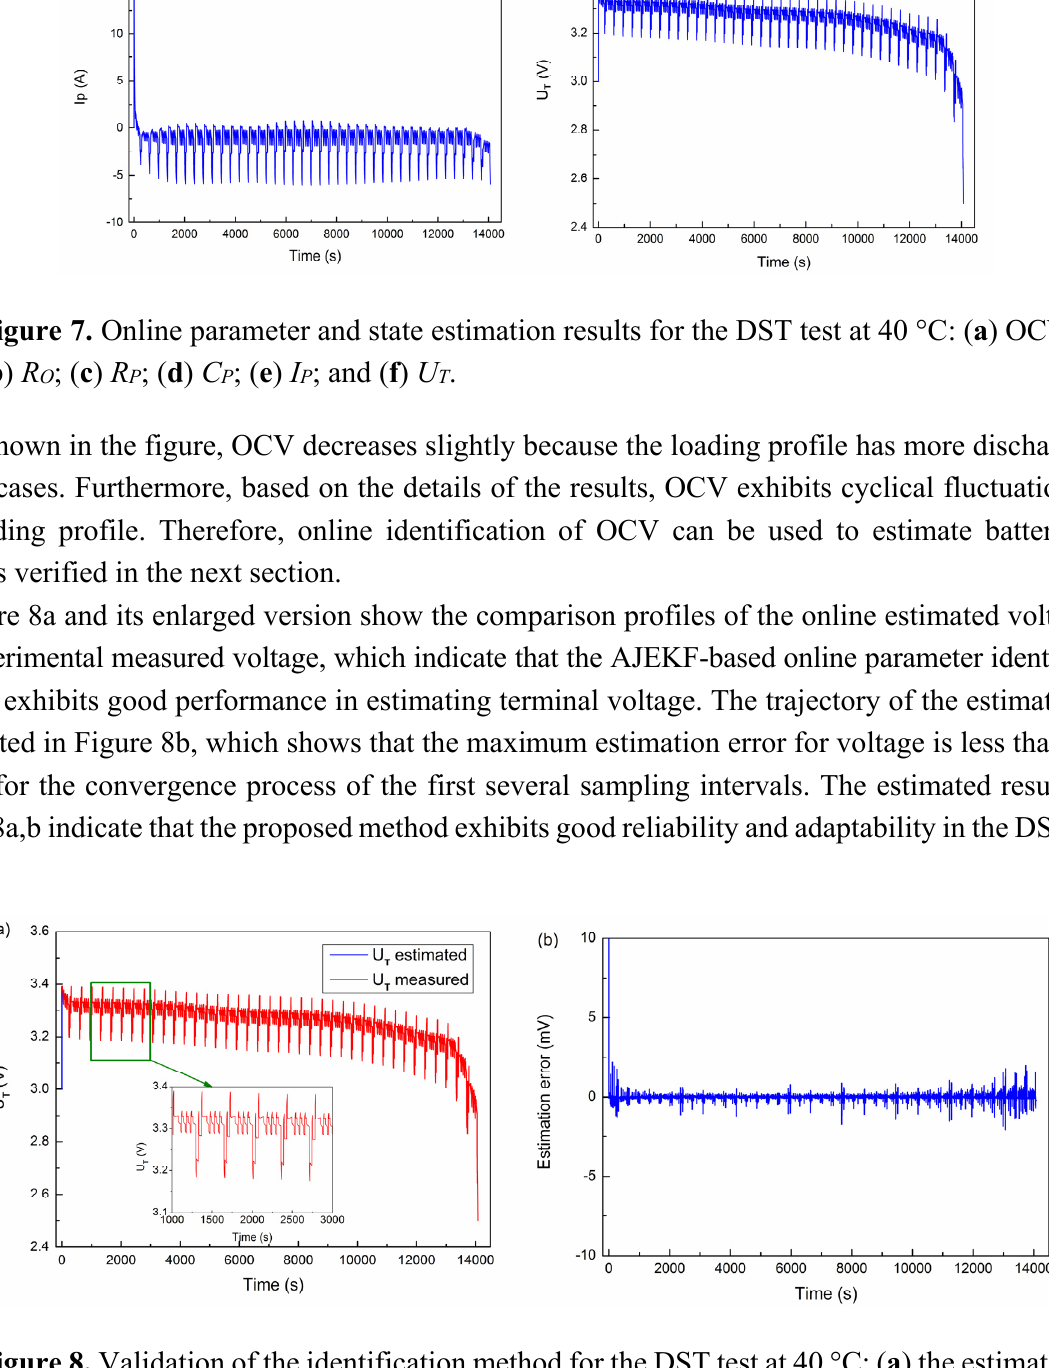
Figure 8. Validation of the identification method for the DST test at 40 °C: ( a ) the estimated voltage and measured voltage profiles and ( b ) the estimation